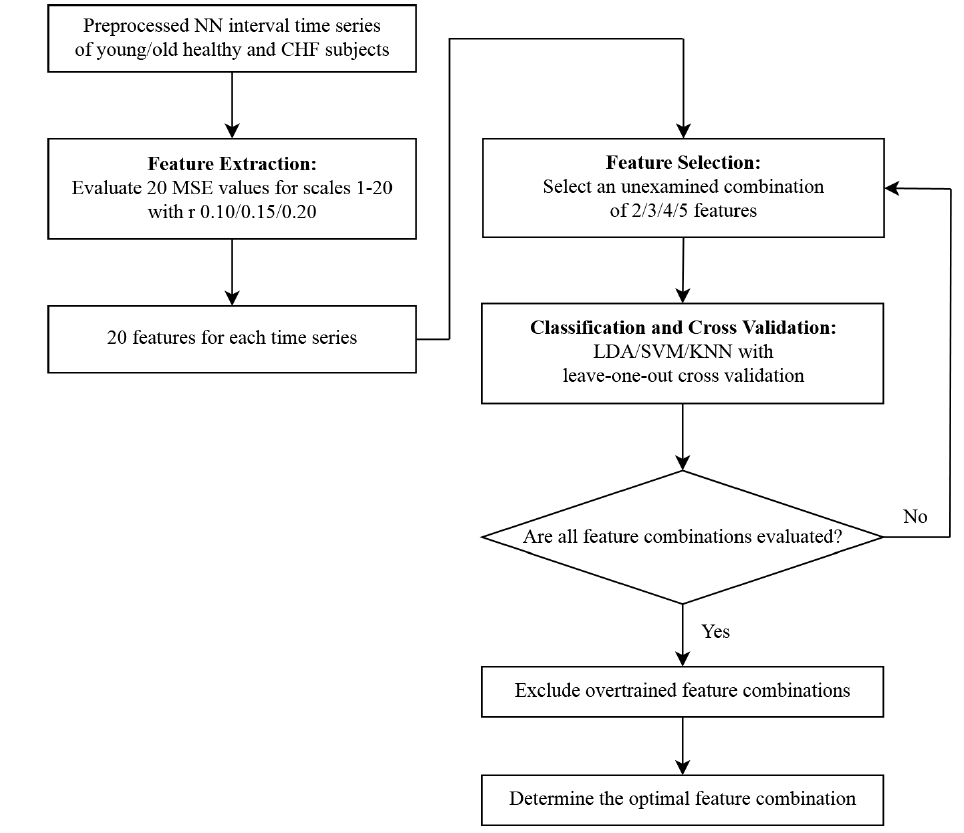
Figure 1. Flowchart of analytical procedure. Note: CHF, congestive heart failure; MSE, multiscale entropy; LDA, linear discriminant analysis; SVM, support vector machine; KNN, k-nearest neighbor.